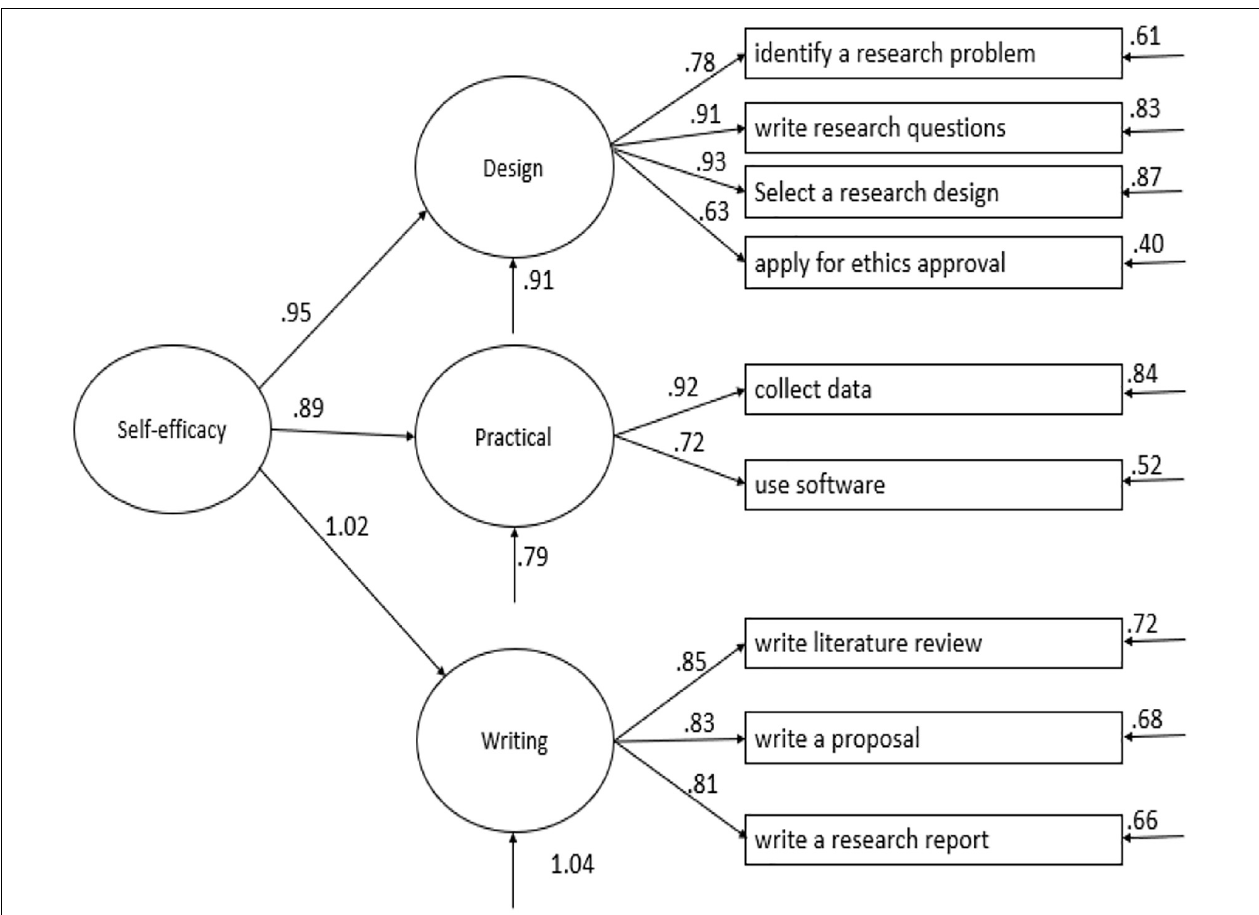
FIGURE 3 | The three-factor correlated model of research self-efficacy. Design, research design skills; practical, practical research skills; writing, writing skills.